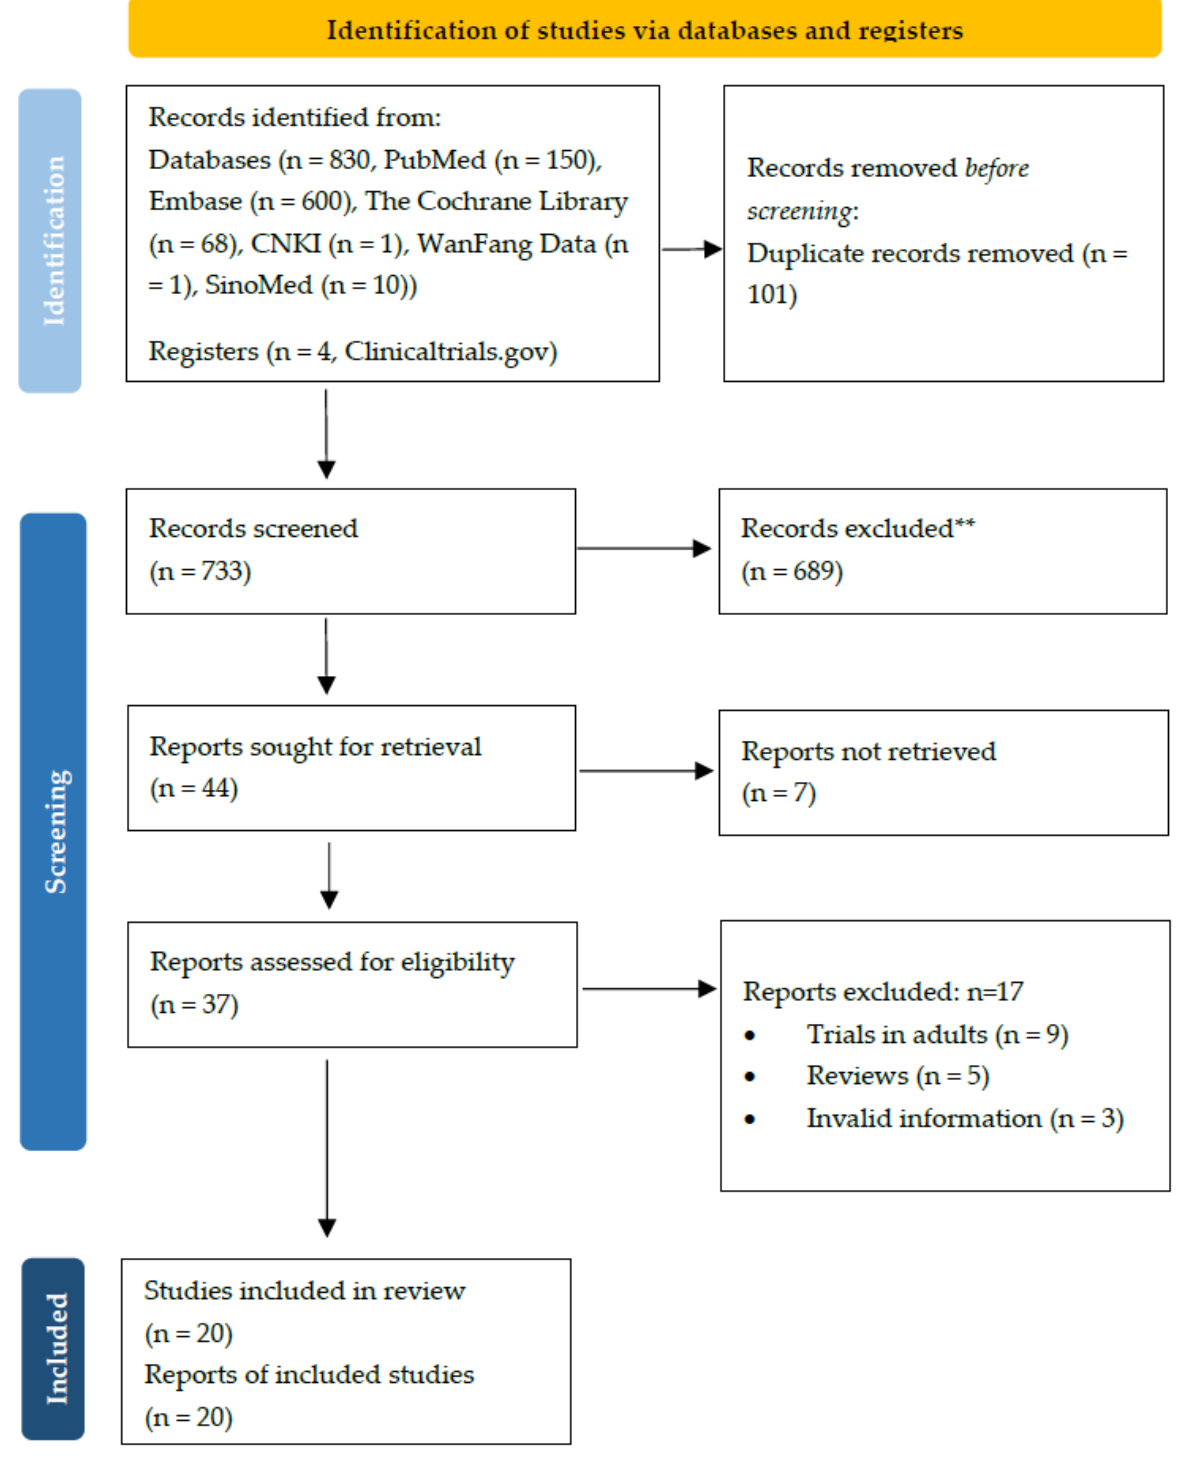
Figure 1. The PRISMA flow diagram.